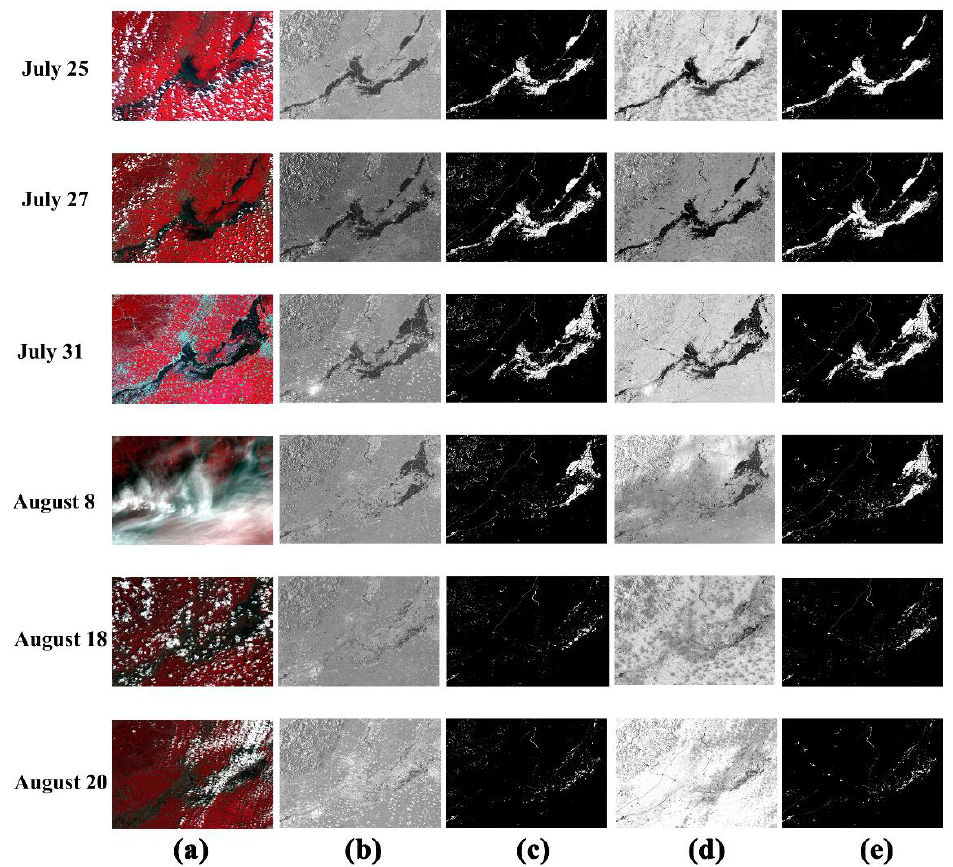
Figure 5. Time series change map of the flood inundation area in Xunxian County, Henan Province: ( a ) Optical image. ( b ) SAR image. ( c ) Water extraction from SAR image. ( d ) SOWI. ( e ) Water extraction from SOWI.